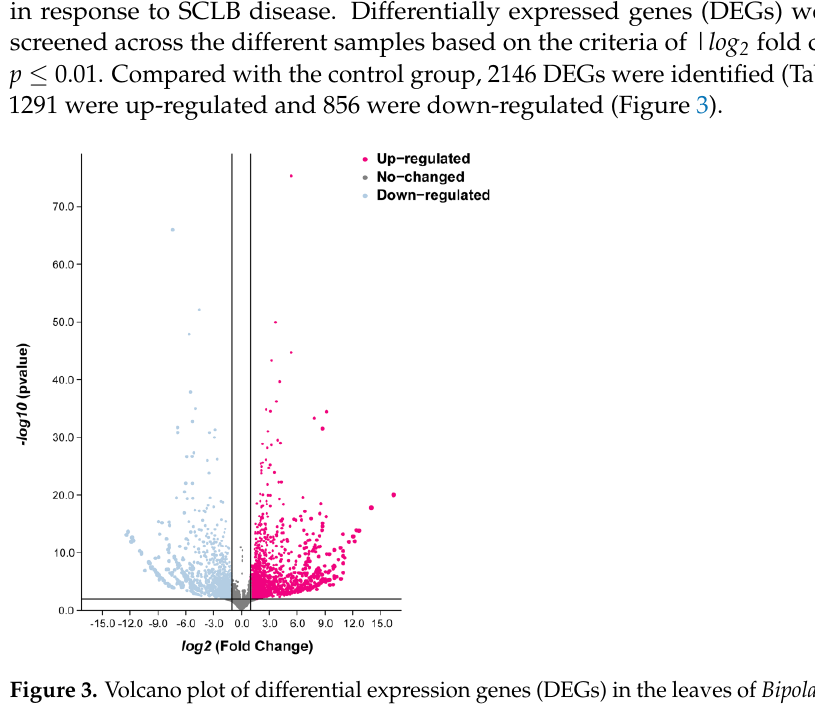
Figure 3. Volcano plot of differential expression genes (DEGs) in the leaves of Bipolaris maydis infected maize plants compared to the control group. Red dots denote up-regulated DEGs, light blue dots denote down-regulated DEGs, and gray dots represent genes with no significant difference.